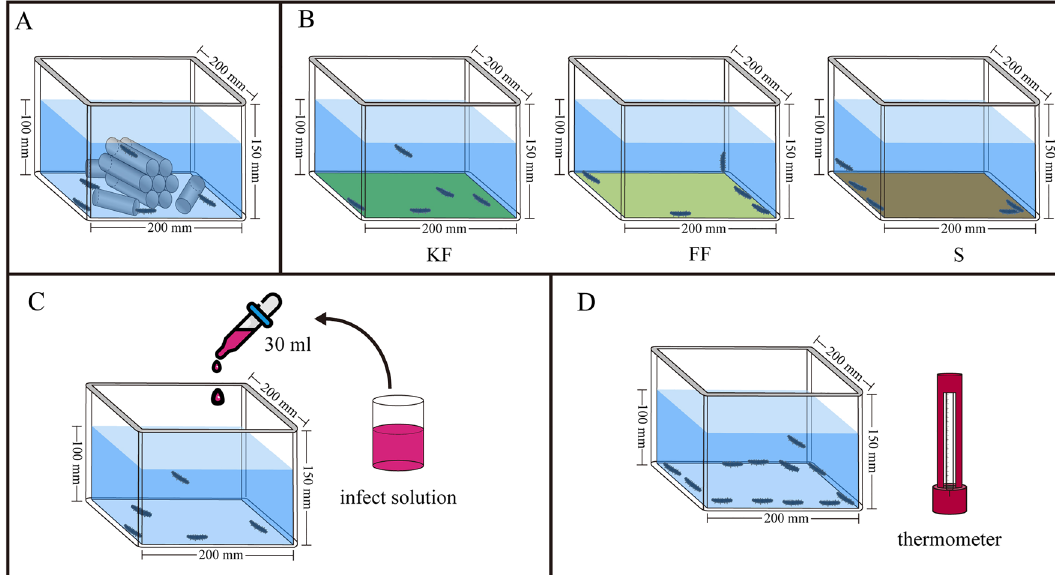
Figure 5. The conceptual diagrams showing the containers for culture ( A ), feeding consumption experiment ( B ), disease challenge assay ( C ), and thermal tolerance ( D ). KF, FF, S refer to KF feces (the feces of sea urchins consumed kelp), FF feces (the feces of sea urchins consumed feed) and the sea cucumber feed (commercial feed mix with sea mud = 1: 6),